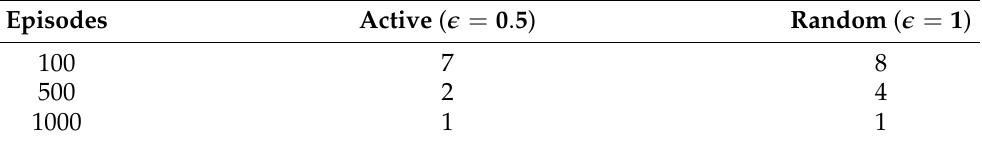
Table 3. Number of sessions without a positively graded weight set by active and random exploration.